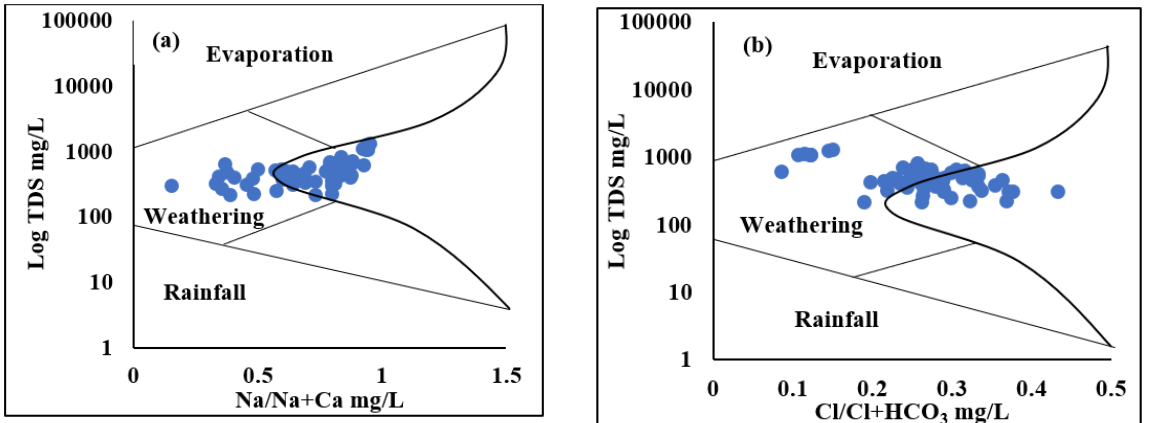
Figure 3. The thematic plot represents the major ion composition controlling the groundwater profile of the Adenzai flood plain region: ( a ) Na + /Na + + Ca ++ mg/L against Log TDS; ( b ) Cl – /Cl – + HCO 3– mg/L against Log TDS.